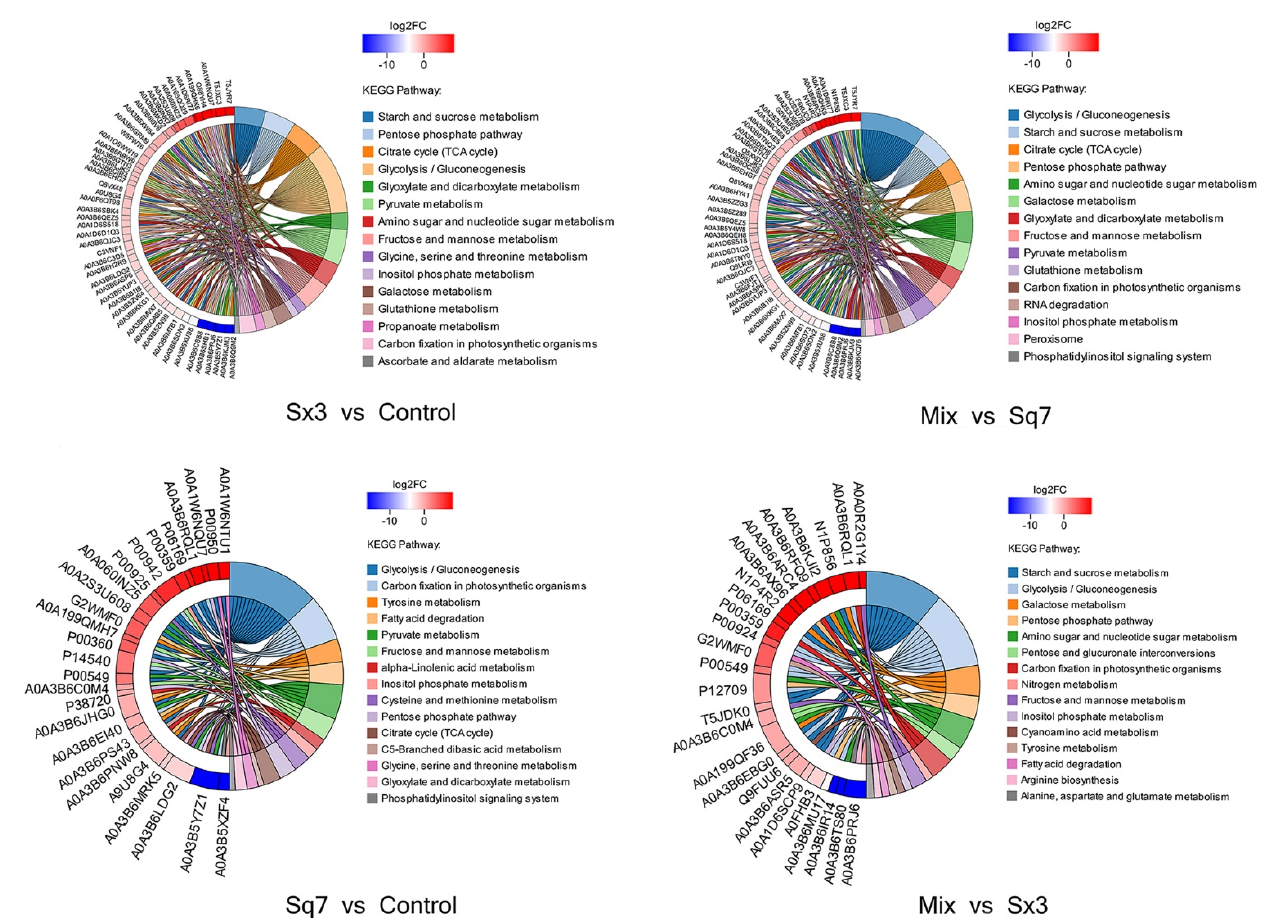
Figure 4. String diagram of protein enrichment in carbohydrate metabolism, the left side is the protein, showing log2FC in order from top to bottom. The larger the log2FC, the greater the fold difference in the expression of upregulated proteins. The smaller the log2FC, the larger the fold difference in the downregulated protein expression. The closer log2FC is to 0, the smaller the differential expression factor of the protein; the right is the name of the KEGG pathway that enriches the target protein.